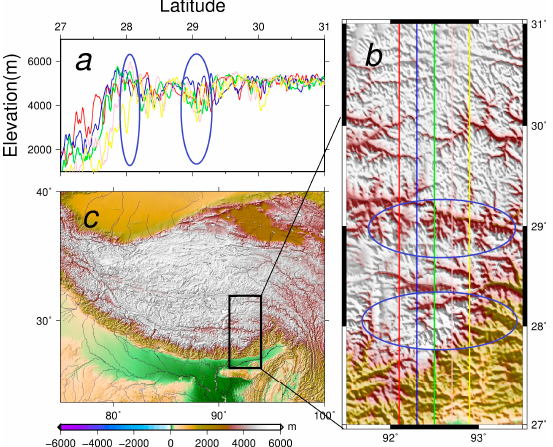
Figure 6. The topography profiles and the roughness of the topography in the Tibetan Plateau ( a ) profile altitudes at different longitudes, the blue ellipse in Figure 6a and Figure 6b the areas analyzed; ( b ) the topography of the computation area, the different color straight lines are located in different longitudes as well as Figure 6a; ( c ) the overview of the topography of the Tibetan Plateau, the black rectangle is the boundary of the computation area.